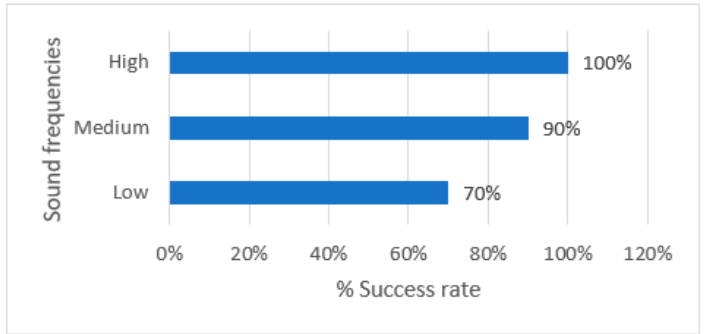
Figure 18. Simulation results of voice samples based on various sound frequencies.